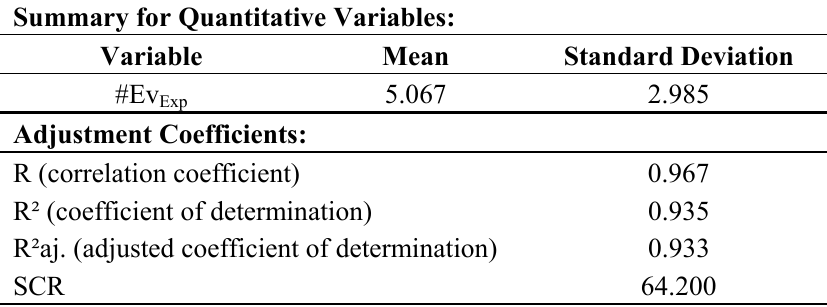
Table 15. Regression Model for #Ev